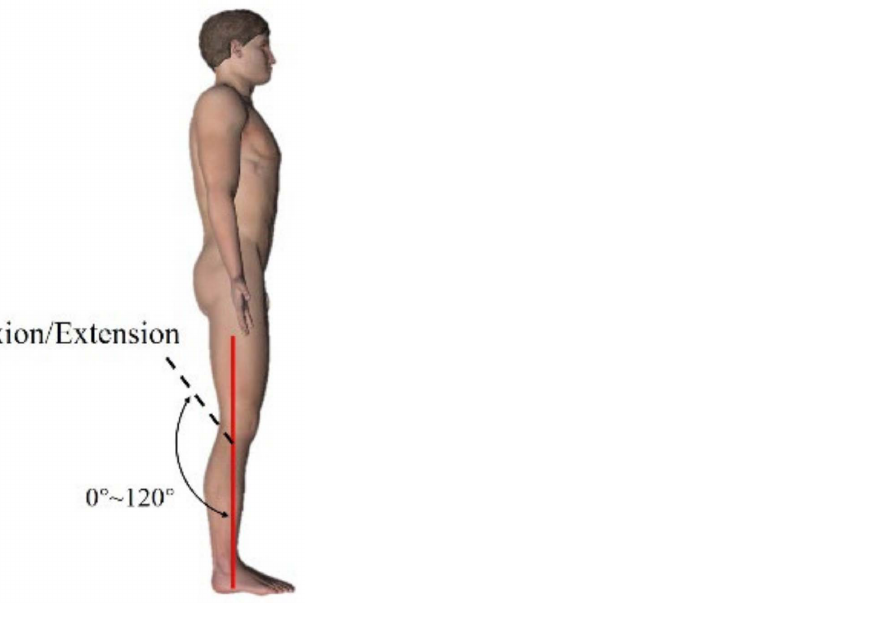
Figure 9. Angle of knee